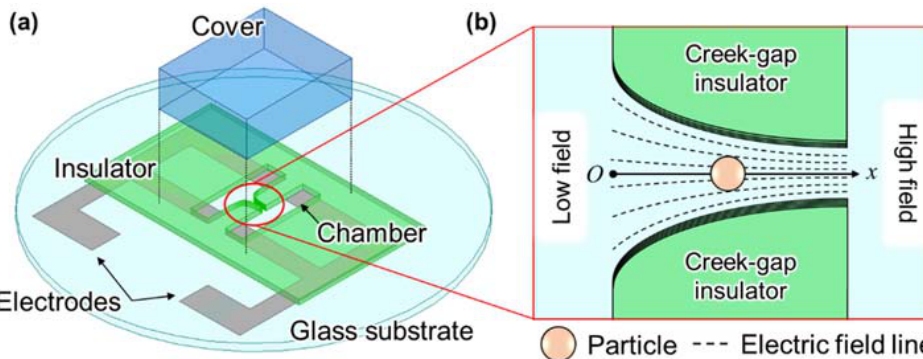
Figure 1. Illustrations of the proposed isomotive iDEP creek-gap device. ( a ) The isometric view of the entire device. ( b ) The enlarged top view of the chamber. A non-uniform electric field was formed by changing the gap between creek-gap insulators.